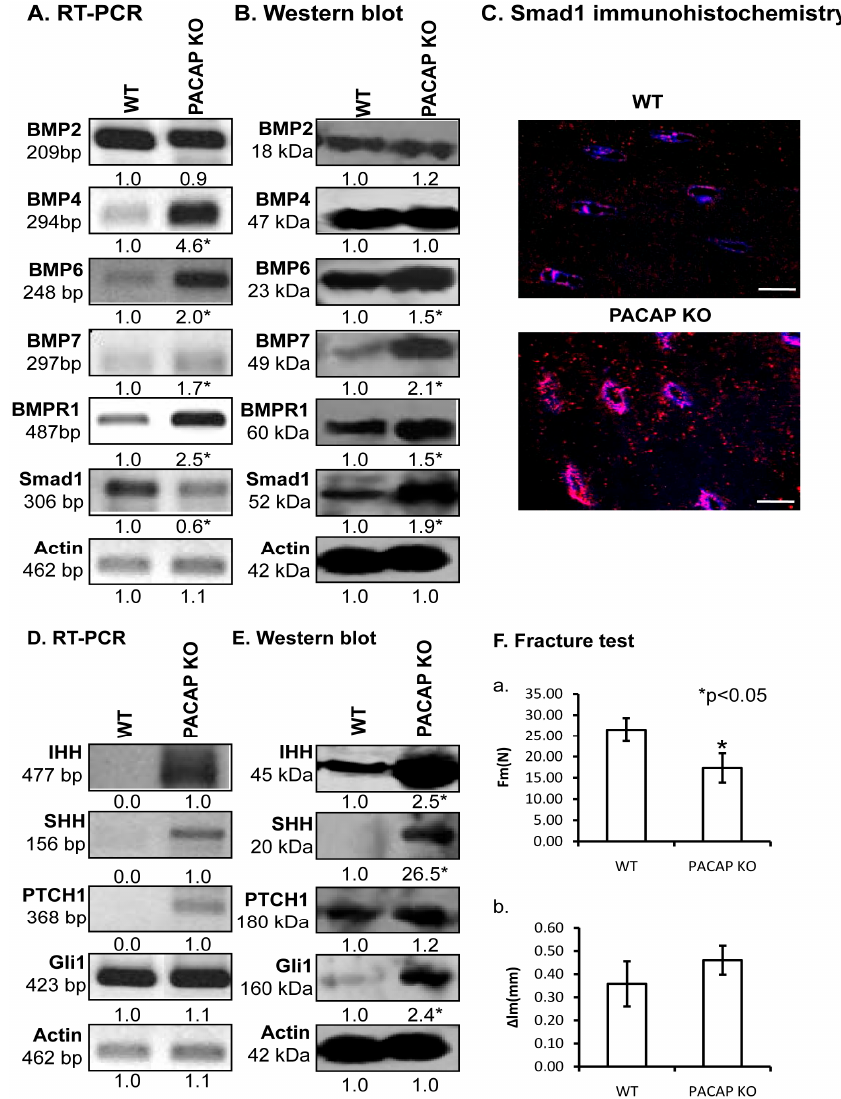
Figure 5. Signalling connections of PAC1 receptor. mRNA ( A , D ) and protein ( B , E ) expression of bone morphogenic protein (BMP)2, BMP4, BMP6, BMP7, BMPR1, Smad1, Indian Hedgehog (IHH), Sonic Hedgehog (SHH), Patched (PTCH)1 and Gli1 in cortical bone. For RT-PCR and Western blot reactions, actin was used as controls. Signals optical density was measured and results were normalised to the optical density of controls. For panels ( A , D ) and ( B , E ) numbers below signals represent integrated densities of signals determined by ImageJ software. ( C ) Smad1 immunohistochemistry in bones. Original magnification was 60 × . Scale bar: 5 µ m. ( F ) Three point bending tests of long bones. ( a ) Value of the loading force at crack (F m ), and ( b ) the value of the bending deformation at crack ( ∆ l m ) were demonstrated. Asterisks indicate significant (* p < 0.05) alteration of expression as compared to the respective control. Representative results of 3 independent